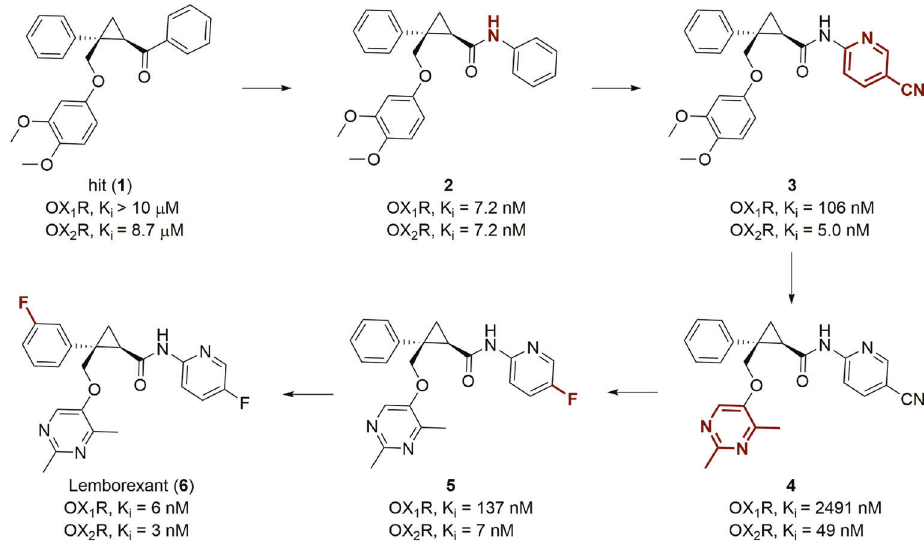
Fig. 3 SAR studies that led to the discovery of the dual orexin receptor antagonist lemborexant